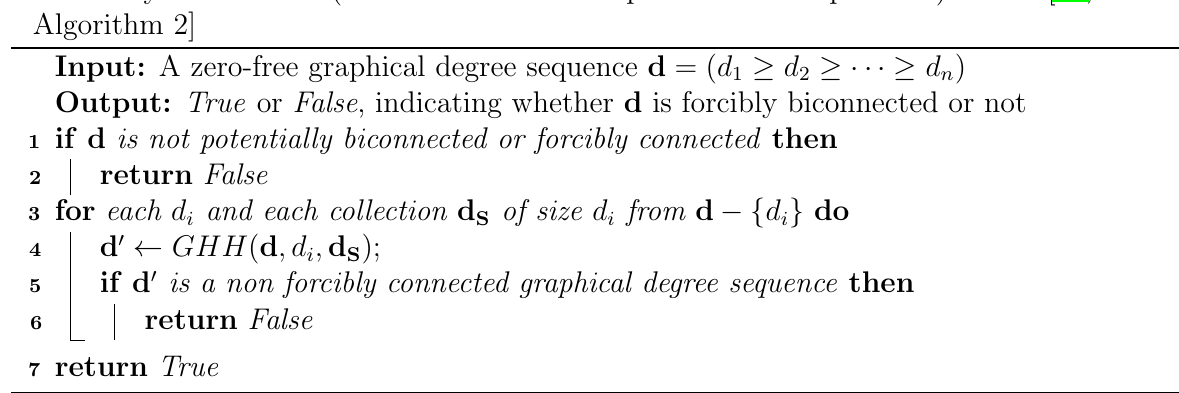
Algorithm 1: basic version pseudo-code to test whether a graphical degree sequence is forcibly biconnected (See text for the description of GHH operation). From [14, Algorithm 2]